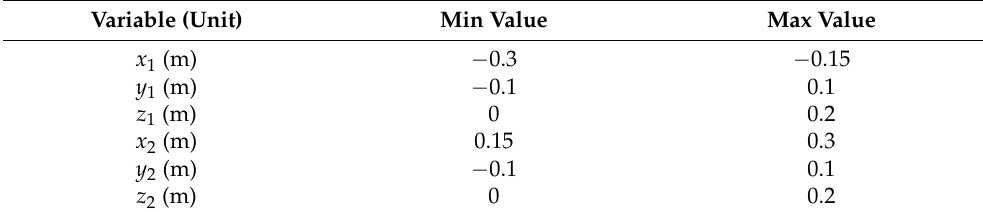
Table 4. Optimization variable ranges.